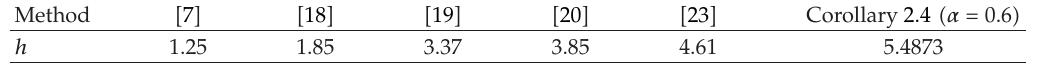
(cid:2) h (cid:8) 0 (cid:3) for di ff erent methods in Example 3.9. 2 1